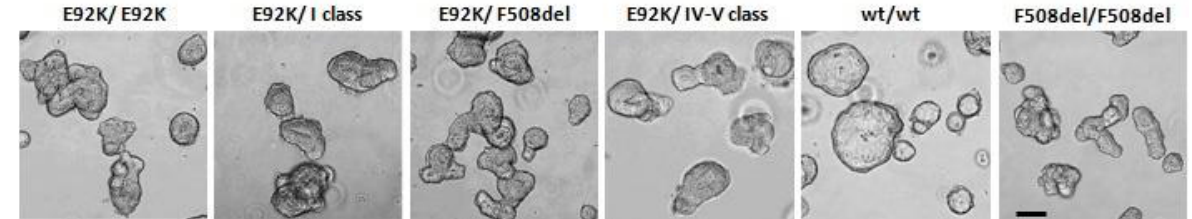
Figure 3. Morphological features of homo-/heterozygous organoids with the E92K-CFTR variant (groups 1–4) in comparison with F508del-homozygous and non-CF control ( wt / wt ) organoids. The scale bar is 200 microns.